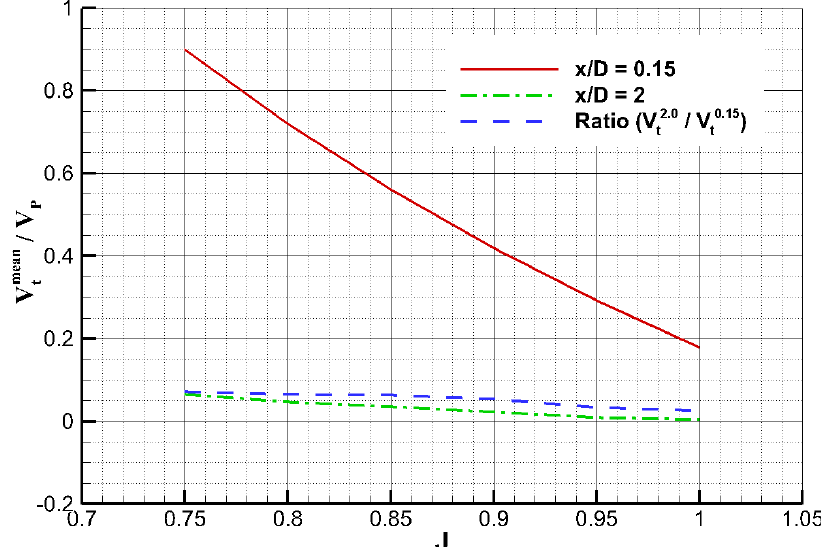
Figure 9. Tangential mean velocities according to advanced ratio for 𝑉 (cid:3021) = 15 m/s.